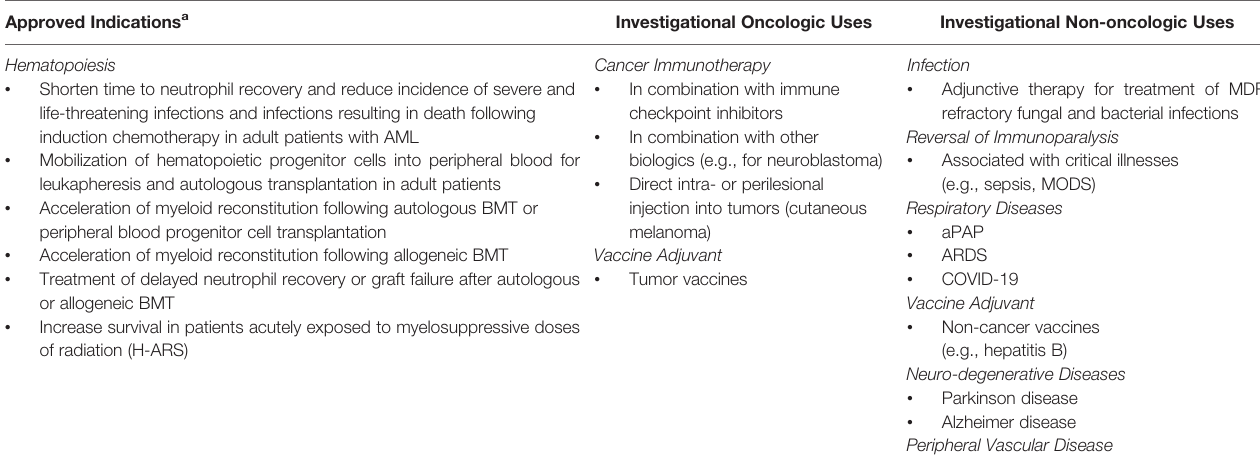
TABLE 1 | Labeled indications and investigational immunomodulatory uses for sargramostim. Approved Indications